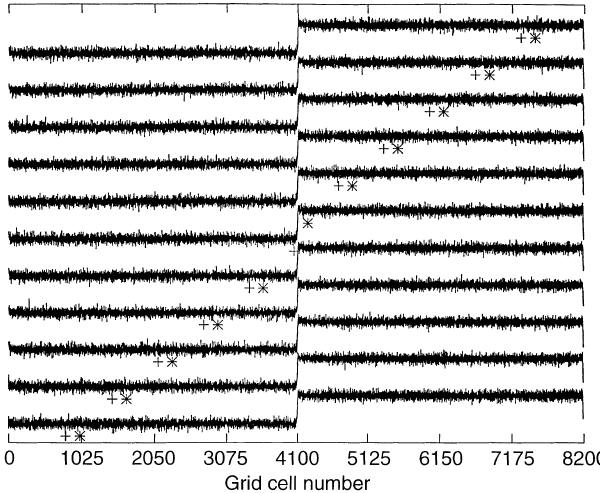
Fig. 1. Stack plot of the magnetic B ? components for the sampling interval and for the time stationary run. The symbol (+) denotes the position ~ x of spacecraft 1 and a ( ) that of spacecraft 2 for the simulation time step t at which the magnetic field was plotted. The exact vertical position of these position indicators is not significant; they are plotted just below the B ? curve to which they refer. The abscissa shows ~